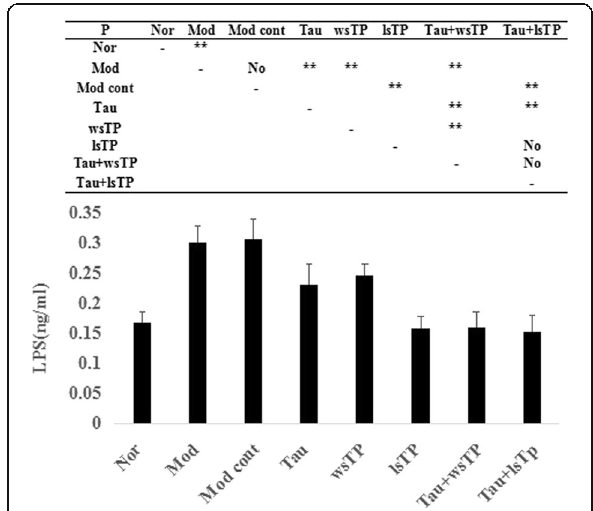
Fig. 3 Effect of taurine and/or TPs on serum LPS level in NASH rats. Results illustrated that high-fat diet increased serum LPS levels significantly compared with the normal group ( P < 0.01). When treated NASH rats with taurine, TPs (wsTP or lsTP), or taurine and TPs (wsTP or lsTP) combination, serum LPS levels all decreased significantly ( P < 0.01), moreover, the LPS levels in NASH rats treated with taurine and wsTP combination were lower than those in NASH rats treated with taurine or wsTP alone ( P < 0.01). The results mentioned above implied that both taurine and TPs (wsTP or lsTP) could decrease serum LPS level in NASH rats, and the combination of taurine and wsTP showed more superior therapeutic effect on NASH than taurine or wsTP alone. LPS, lipopolysaccharide; NASH, nonalcoholic steatohepatitis; Nor, normal group; Mod, model group; Mod cont, model control group; Tau, taurine treatment group; wsTP, water soluble tea polyphenols treatment group; lsTP, lipid soluble tea polyphenols treatment group; Tau + wsTP, taurine and water soluble tea polyphenols treatment group; Tau + lsTP, taurine and lipid soluble tea polyphenols treatment group; “ ** ” p < 0.01; “ No ” p >